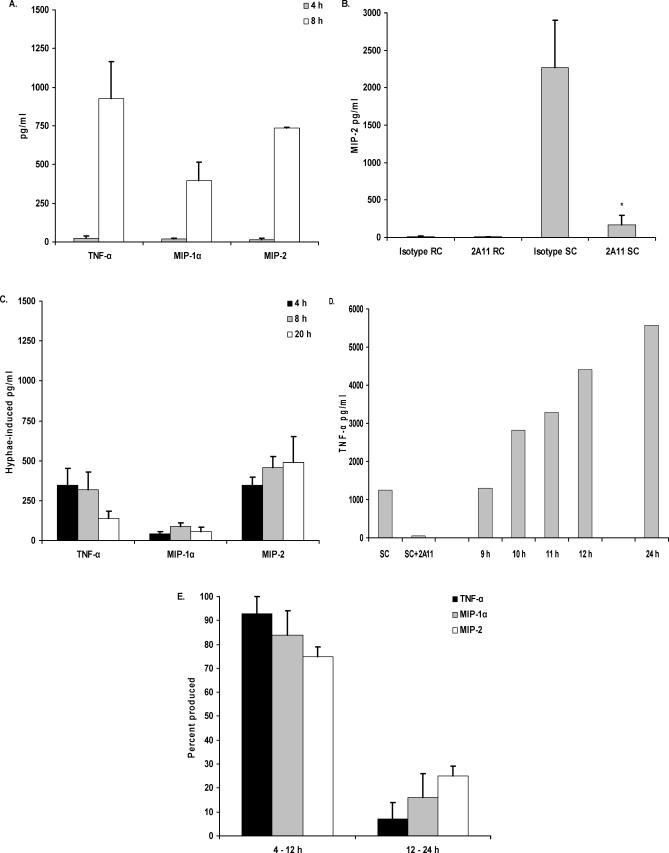
Cytokine and Chemokine Production Is Dependent on Beta-Glucan Recognition in A. fumigatus SC and Pre-Competent HyphaeAlveolar macrophages were added to (A) live A. fumigatus RC and incubated for 4 h and 8 h, (B) live RC or SC and incubated for 4 h in the presence of isotype or 2A11, or (C) live A. fumigatus hyphae and incubated for 4 h, 8 h, and 24 h. (D and E) Alveolar macrophages were added to A. fumigatus RC and incubated for 24 h. Samples for cytokine analysis were taken between 9 h and 12 h, and at 24 h, as indicated. Also shown in (D) is a representative 4-h response to pre-generated SC, and inhibition of this response by 2A11. Thereafter, cytokine and chemokine levels were determined in supernatants by Bio-Plex or ELISA. Percentage data expressed in (E) were calculated by dividing the pg/ml cytokine/chemokine level in 12-h samples by that in 24-h samples. Asterisks represent significant differences between isotype (rat IgG) and 2A11 (p < 0.05). (A–C,E, and F) are cumulative results from four experiments.